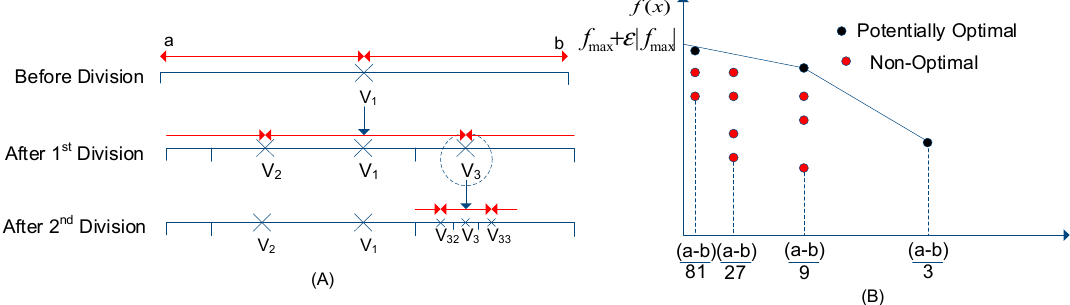
Figure 14. ( A ) Dividing strategy method, ( B ) potential optimal interval method.